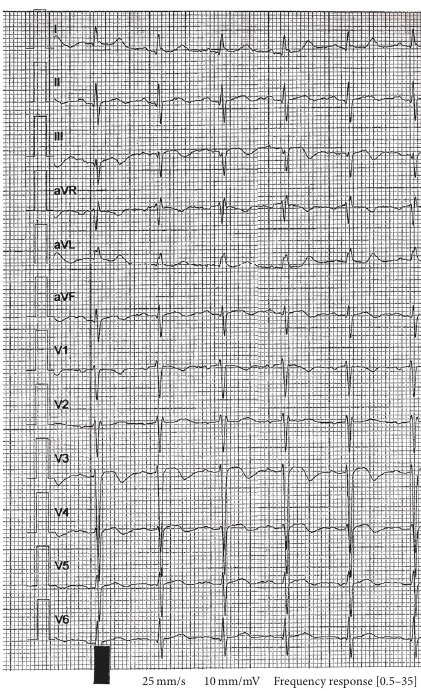
Figure 1: Photograph of ECG demonstrating a small Q wave with S and T waves that can be seen in lead III, the inferior leads (II, III, and aVF), T wave inversions in the right precordial leads (V1–4), and clockwise rotation-shift of the R/S transition point towards V6 with a persistent S wave in V6, all consistent with pulmonary embolism (settings: 25 mm/s and